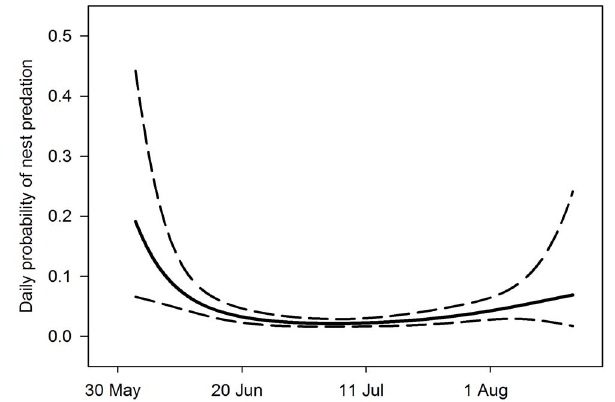
Figure 2. Seasonal variation in foliage density at nest sites. Percent of the nest site obscured by foliage density within 1-m radius surrounding Dusky Flycatcher nests increased with date in a non-linear fashion (Mean percent foliage density for nests on the same day 6 SE). Measures of foliage density represent average nest concealment measurements for a collection of nests measured on the same